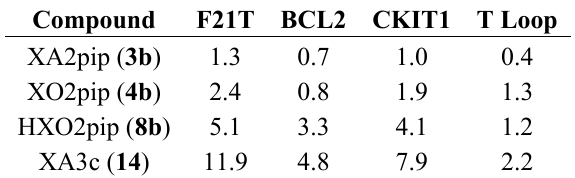
Table 5. Δ T data at 1 μ M ligand concentration (with 60 mM K + at pH 7.4). Esds are ±0.1 m